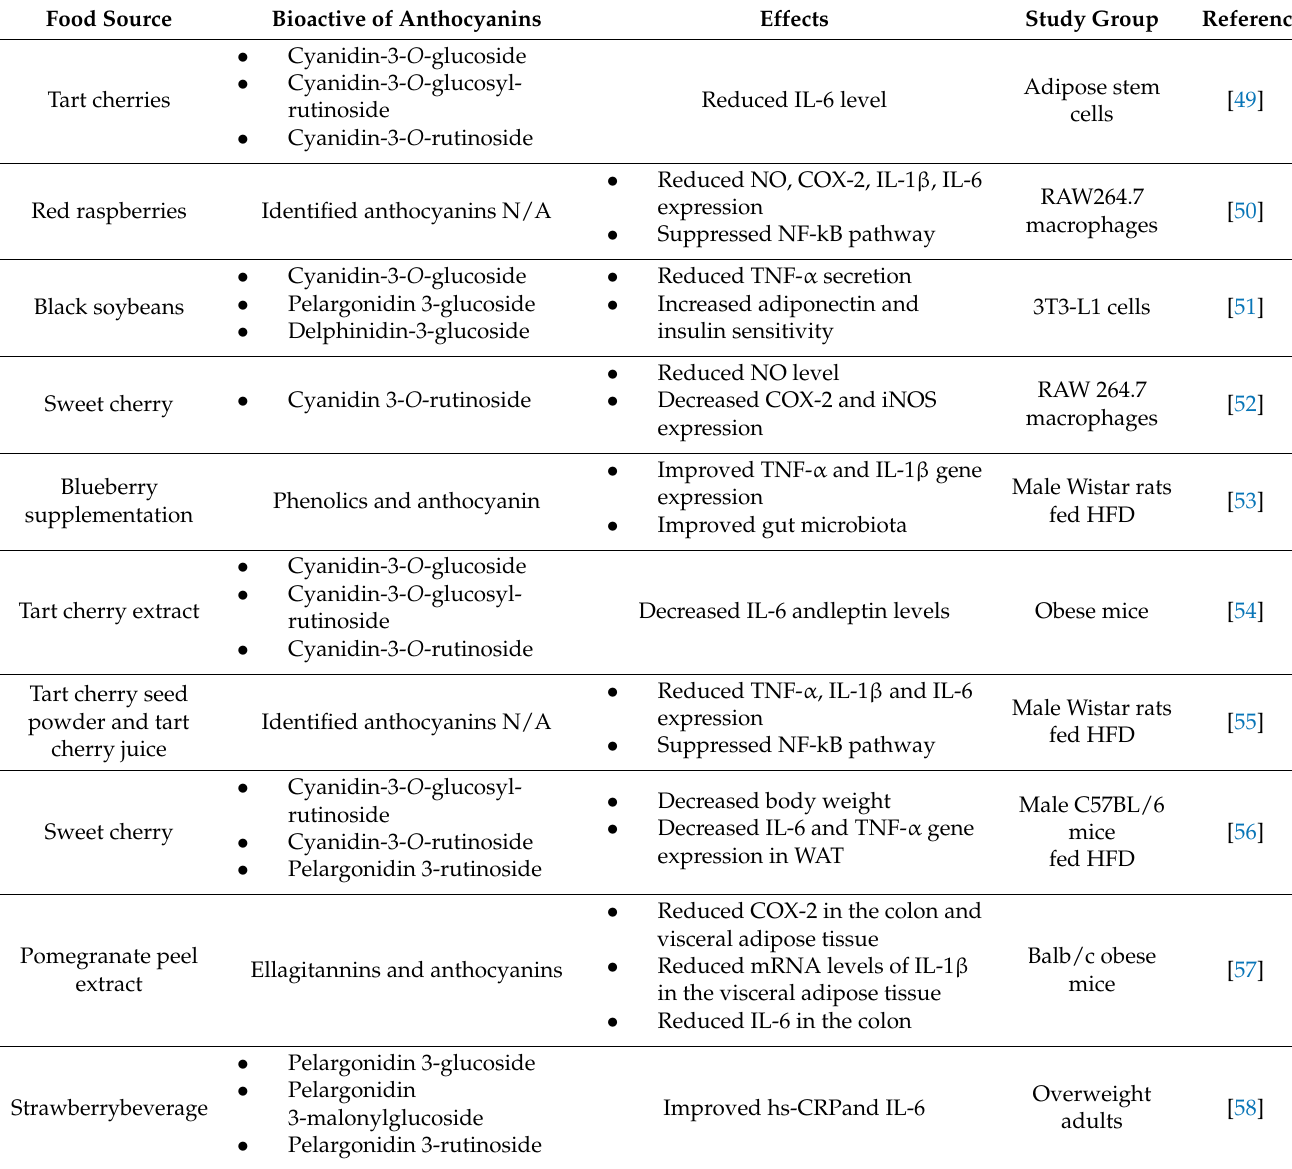
Table 2. Effects of anthocyanins on obesity-associated inflammation